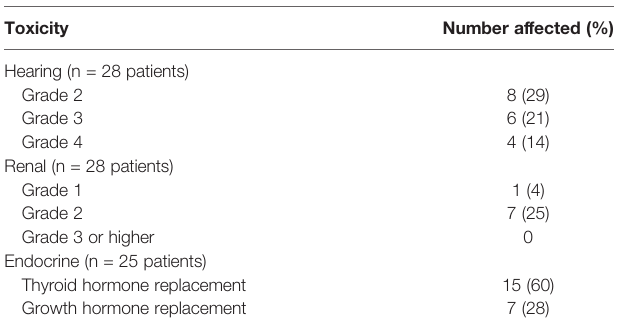
TABLE 2 | Evaluated toxicities.